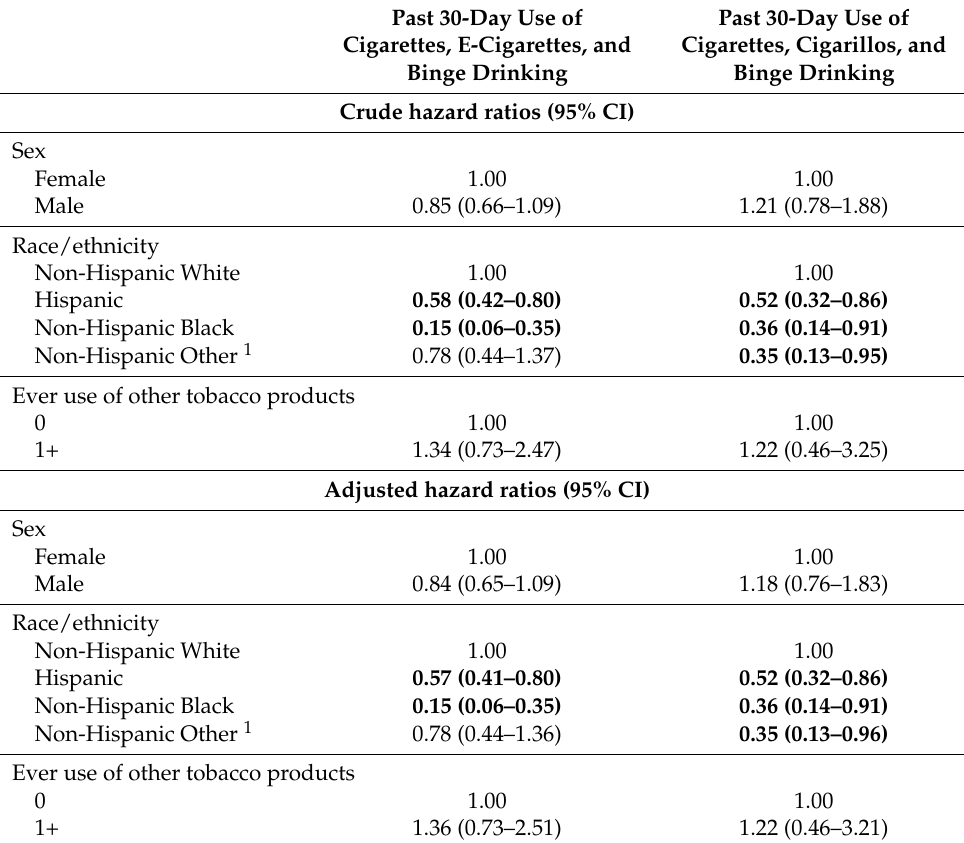
Table 3. Crude and adjusted hazard ratios (with 95% confidence intervals) for the age of initiation of past 30-day polysubstance use outcomes in PATH ¥ youth (2013–2019). Past 30-Day Use of Past 30-Day Use of Cigarettes, E-Cigarettes, and Cigarettes, Cigarillos, and Binge Drinking Binge Drinking Crude hazard ratios (95%